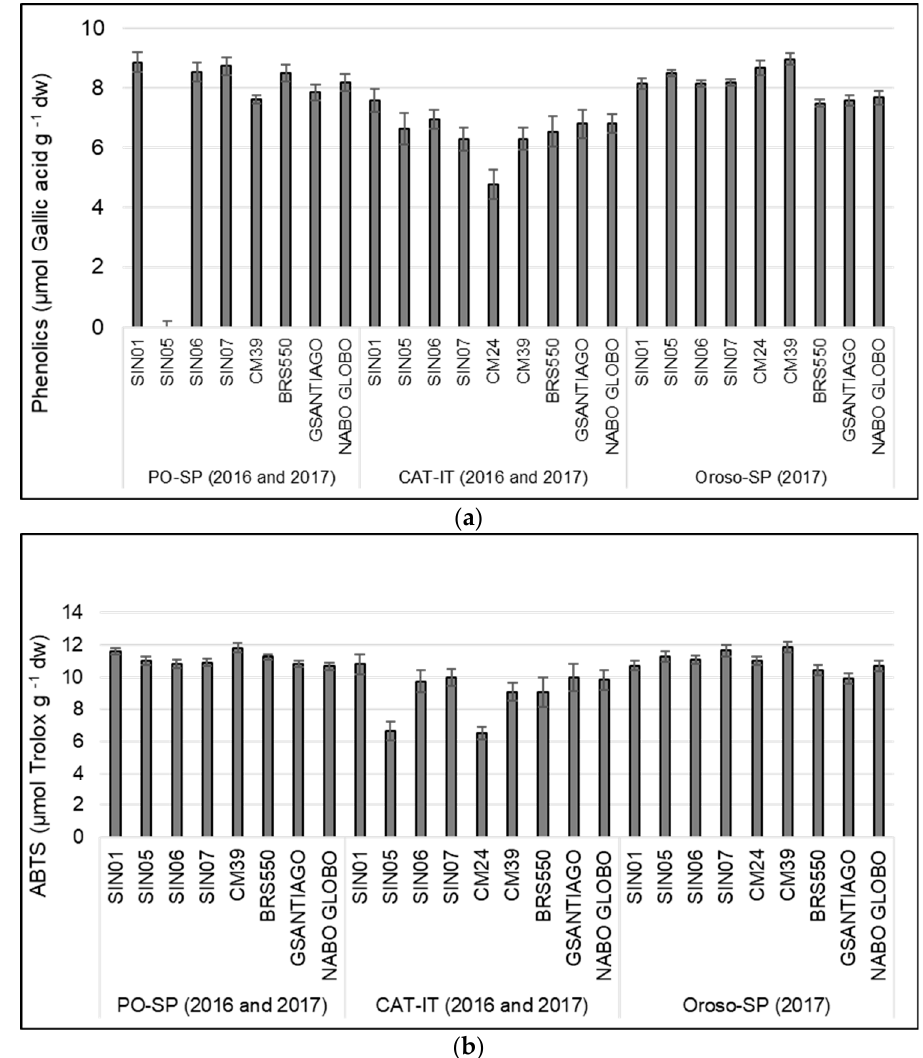
Figure 3. Phenolic content ( a ) and antioxidant activity measured with ABTS assays ( b ) in leaves (turnip greens) of nine B. rapa varieties grown at five environments in North Weast Spain and in South Italy for two years. Significant differences among environments ( p < 0.001).